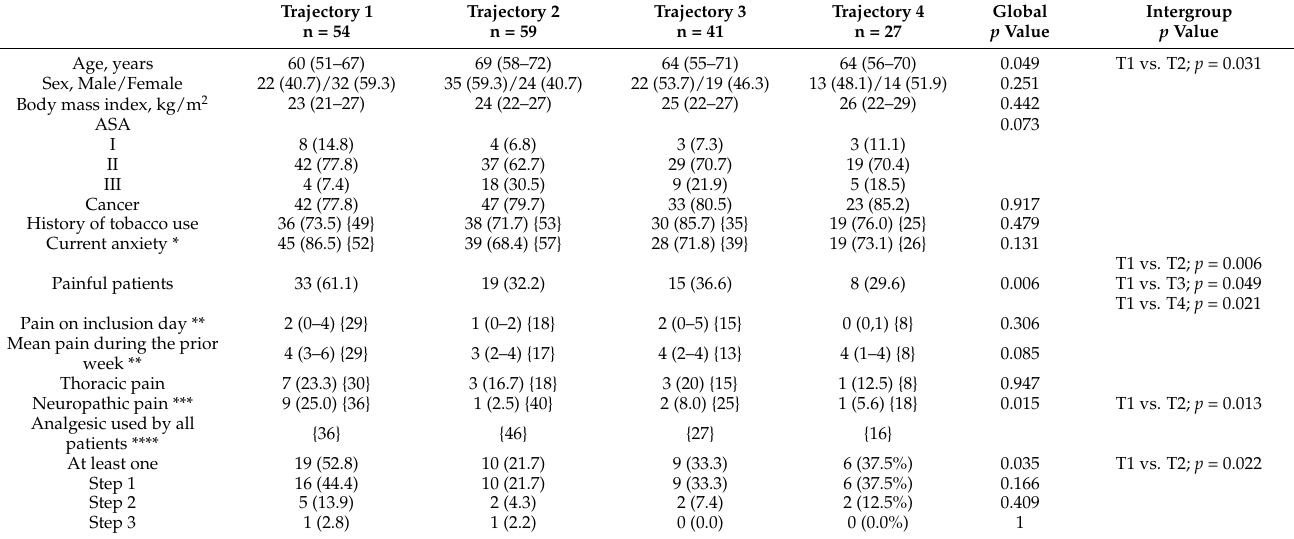
Table 4. Patient characteristics at inclusion for each trajectory group.